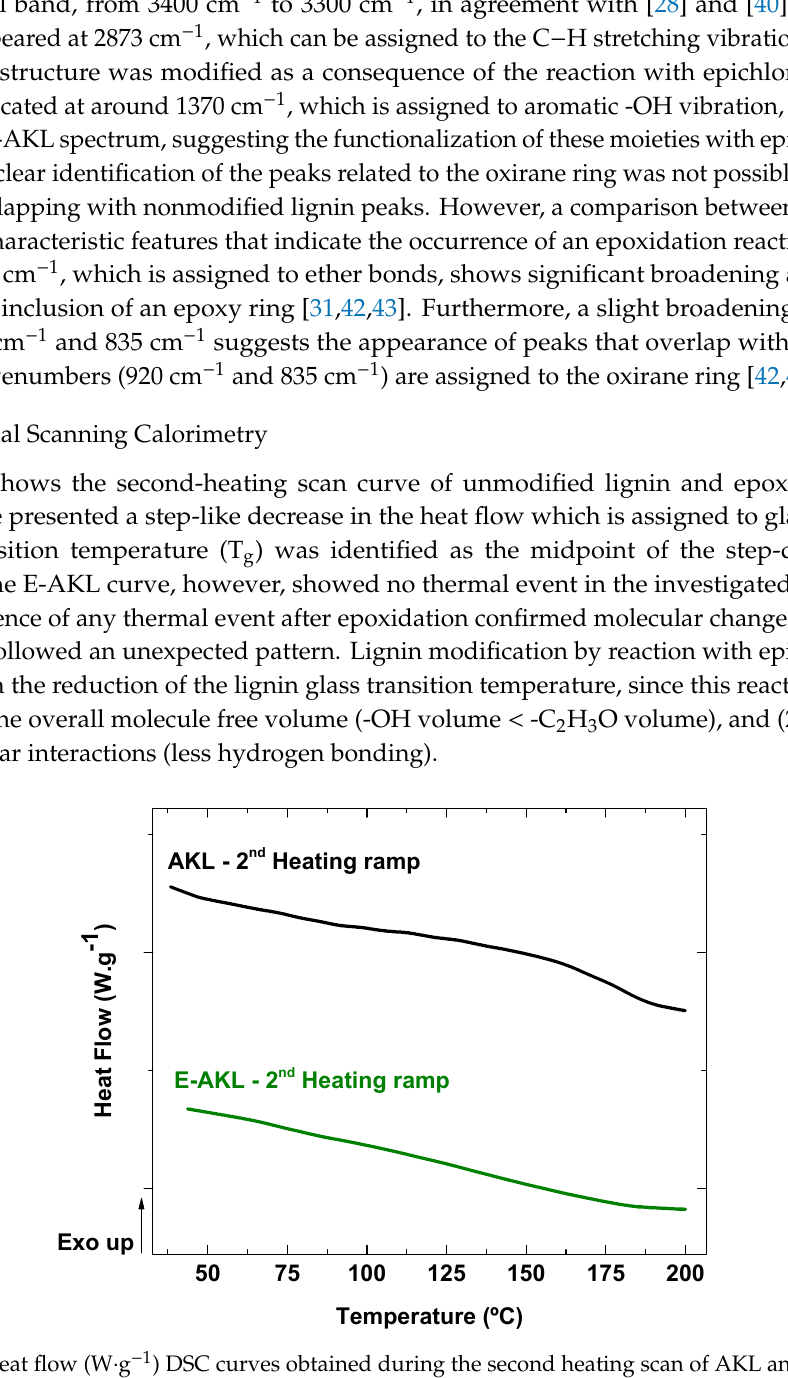
Figure 4. Heat flow (W · g − 1 ) DSC curves obtained during the second heating scan of AKL and E-AKL.